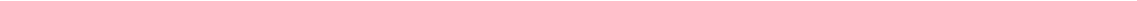
(see fi gure on previous page) Fig. 2 Folate de fi ciency upregulates Gcm1 to promote formation of the Gcm1/ β -catenin/TCF4 complex. a Differentially expressed NTD- related genes in the microarray expression pro fi les of C57BL/6 mESCs cultured in folate-de fi cient conditions for six generations. The microarray data were obtained from three replicates for both control and folate-de fi cient cells. The X -axis represents the Log2 fold change. b The mRNA expression of Gcm1 in C57BL/6 mESCs after six generations of folate de fi ciency. ** P = 0.004. c Increased expression of Gcm1 in mESCs with folate de fi ciency. Top panel: western blots of Gcm1 in control and folate-de fi cient cells; bottom panel: bar graph showing the quanti fi cation of the western blot signal intensities. d Ef fi ciency of siRNA-mediated Gcm1 and siRNA-mediated TCF4 depletion and the expression of TCF4, Gcm1 and Axin2 at the protein level in C57BL/6 mESCs. mESCs with folate de fi ciency were transfected into either scramble siRNA control or Gcm1 siRNA and TCF siRNA, and post 72 h of transfection, the expression was determined by western blotting. e Ef fi ciency of siRNA-mediated Gcm1 and TCF4 depletion and the expression of TCF4 and Axin2 at the protein level in NE-4C. NE-4C with folate de fi ciency were transfected into either scramble siRNA control or Gcm1 siRNA, TCF4-siRNA, and the expression was determined 72 h post transfection by western blotting. f A coimmunoprecipitation (Co-IP) assay was used to identify the interaction between Gcm1, β -catenin, and TCF4 in C57BL/6 mESC. Immunoprecipitation (IP) was performed using an anti- Gcm1 antibody and TCF4 antibody, and immunoblotting (IB) was performed using an anti- β -catenin antibody. g A Co-IP assay was used to identify the interactions between Gcm1 and TCF4, β -catenin in NE-4C. An anti-Gcm1 antibody and anti-TCF4 antibody was used for IP, and an anti-TCF4 antibody and anti- β -catenin was used for IB. Data b – f represent the mean ± SEM ( n = 3). The p value was calculated by Student ’ s t -test, ns was for no signi fi cance, * P < 0.05, ** P < 0.01, *** P <